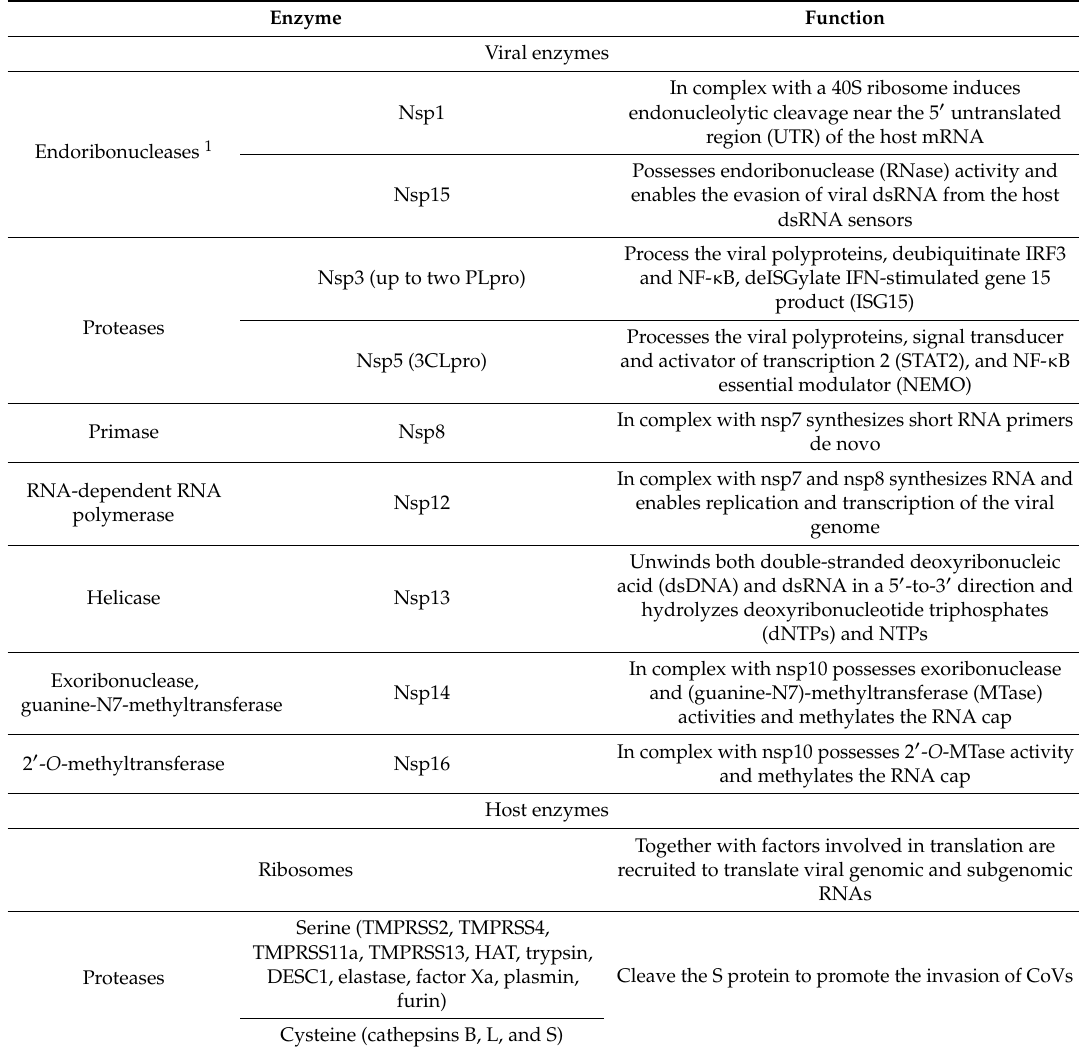
Table 1. CoV and host enzymes supporting the viral life